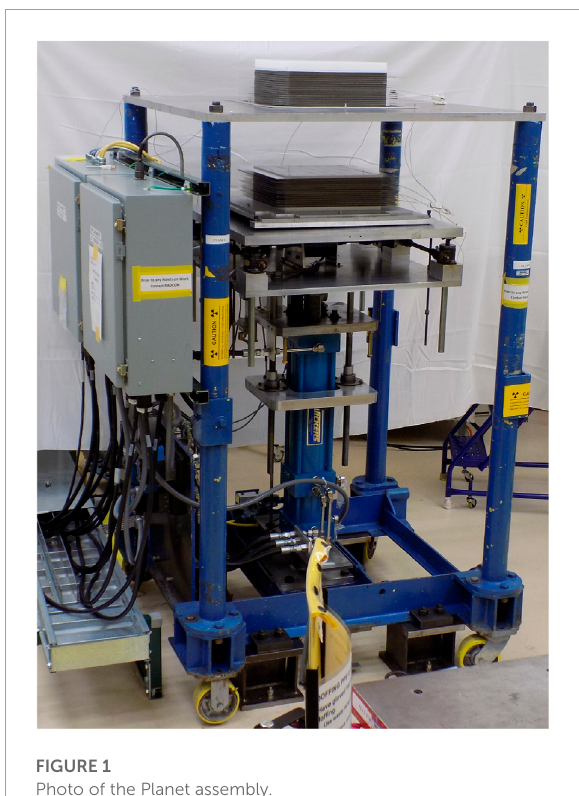
FIGURE 1 Photo of the Planet assembly.